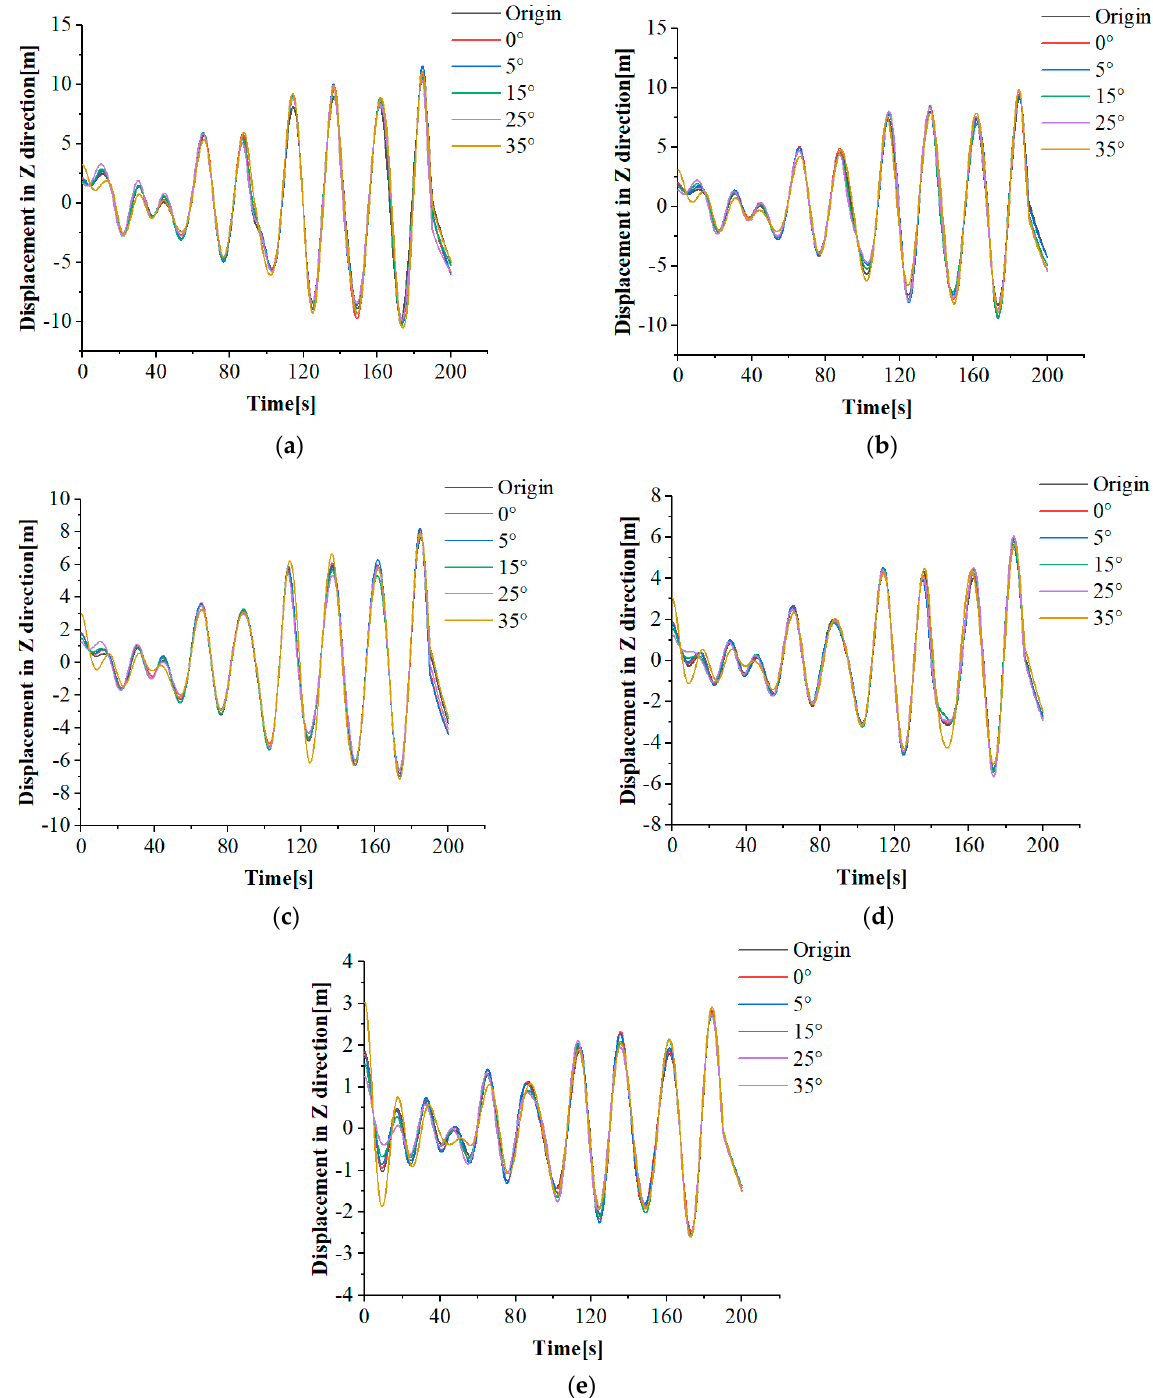
Figure 29. Z direction displacement of the pedestal under different chamfers. ( a ) H = 9 m; ( b ) H = 7.2 m; ( c ) H = 5.4 m; ( d ) H = 3.6 m; ( e ) H = 1.8 m.